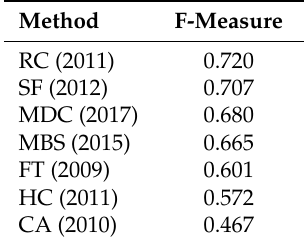
Table 1. The list of models ranked by their F-measure. The individual models are ranked according to the obtained F-measure on the iCoseg dataset from higher to lower